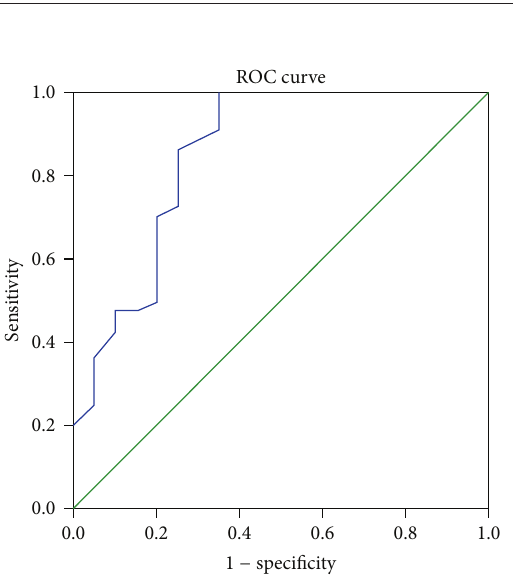
Figure 1: Roc diagram showing correlation of total ONSD and the CSF